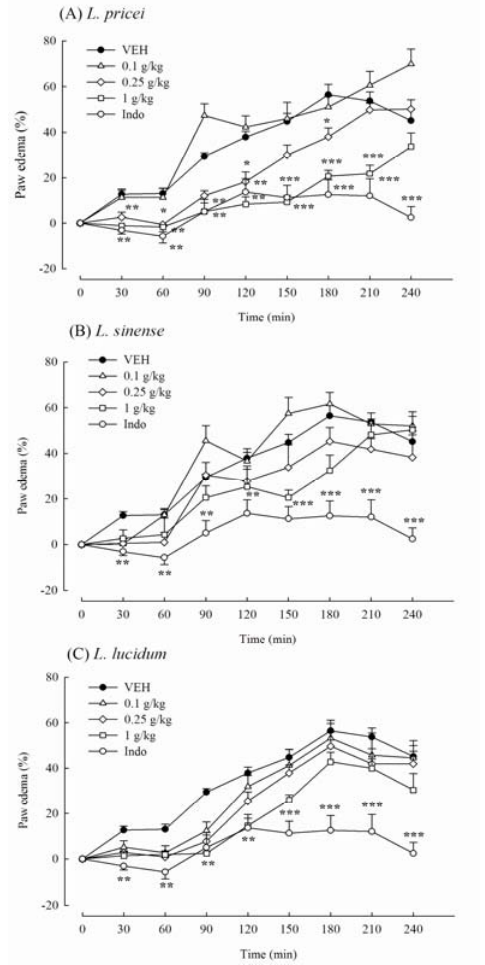
Figure 3. Effects of methanol extracts from Ligustrum plants leaves (0.1, 0.25, 1 g/kg) and indomethacin (Indo, 10 mg/kg) on carrageenan-induced paw edema in